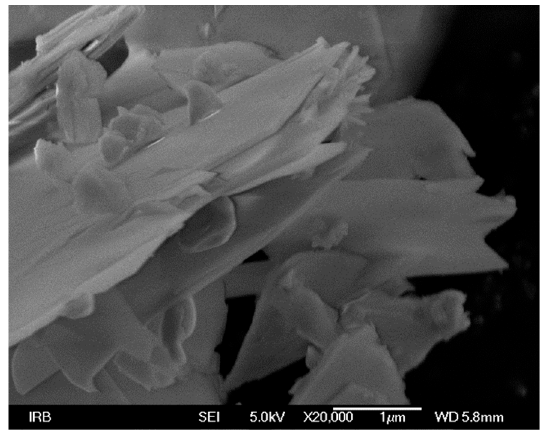
Figure 4. FE-SEM images of pure ( a ) ZnO, and ( b ) PANI/ZnO_1, ( c ) PANI/ZnO_2, and ( d ) PANI/ZnO_3 samples. Images ( b ), ( c ), and ( d ) show the impact of the prolonged stirring time on the morphology of prepared PANI/ZnO samples. Composites particles size: PANI/ZnO_1 > PANI/ZnO_2 > PANI/ZnO_3.